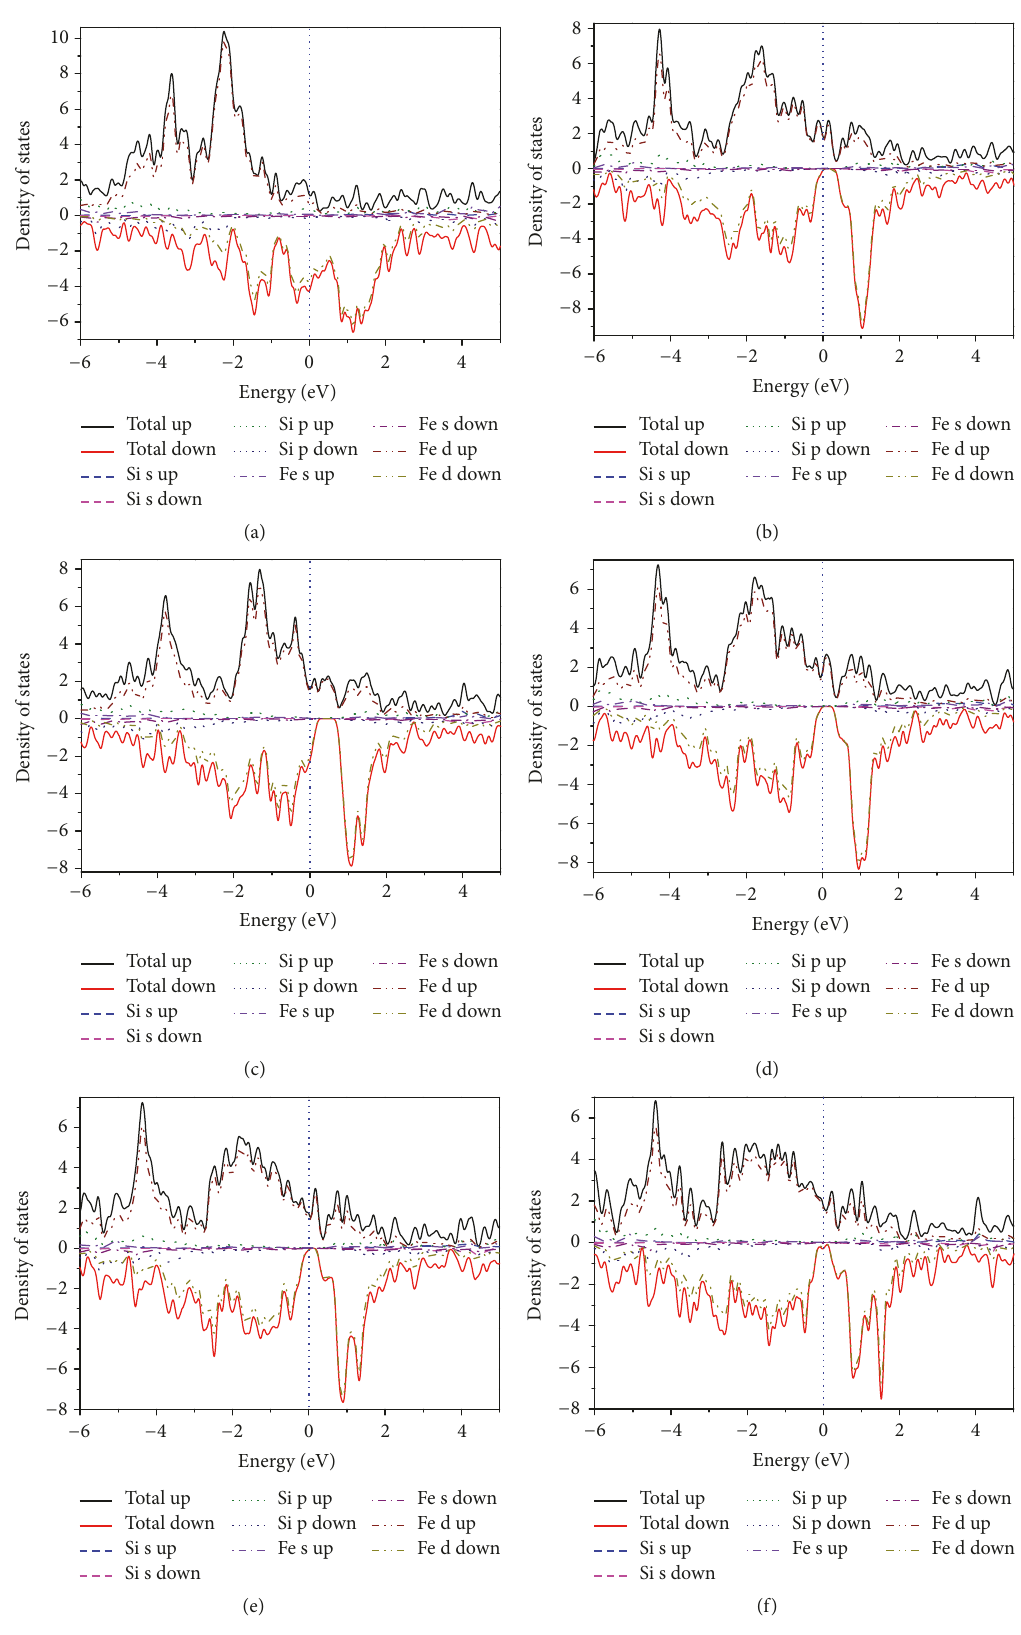
Figure 2: DOS of Fe 2 Si under various strains: (a) − 12%, (b) − 7%, (c) 0%, (d) 5%, (e) 9%, and (f)